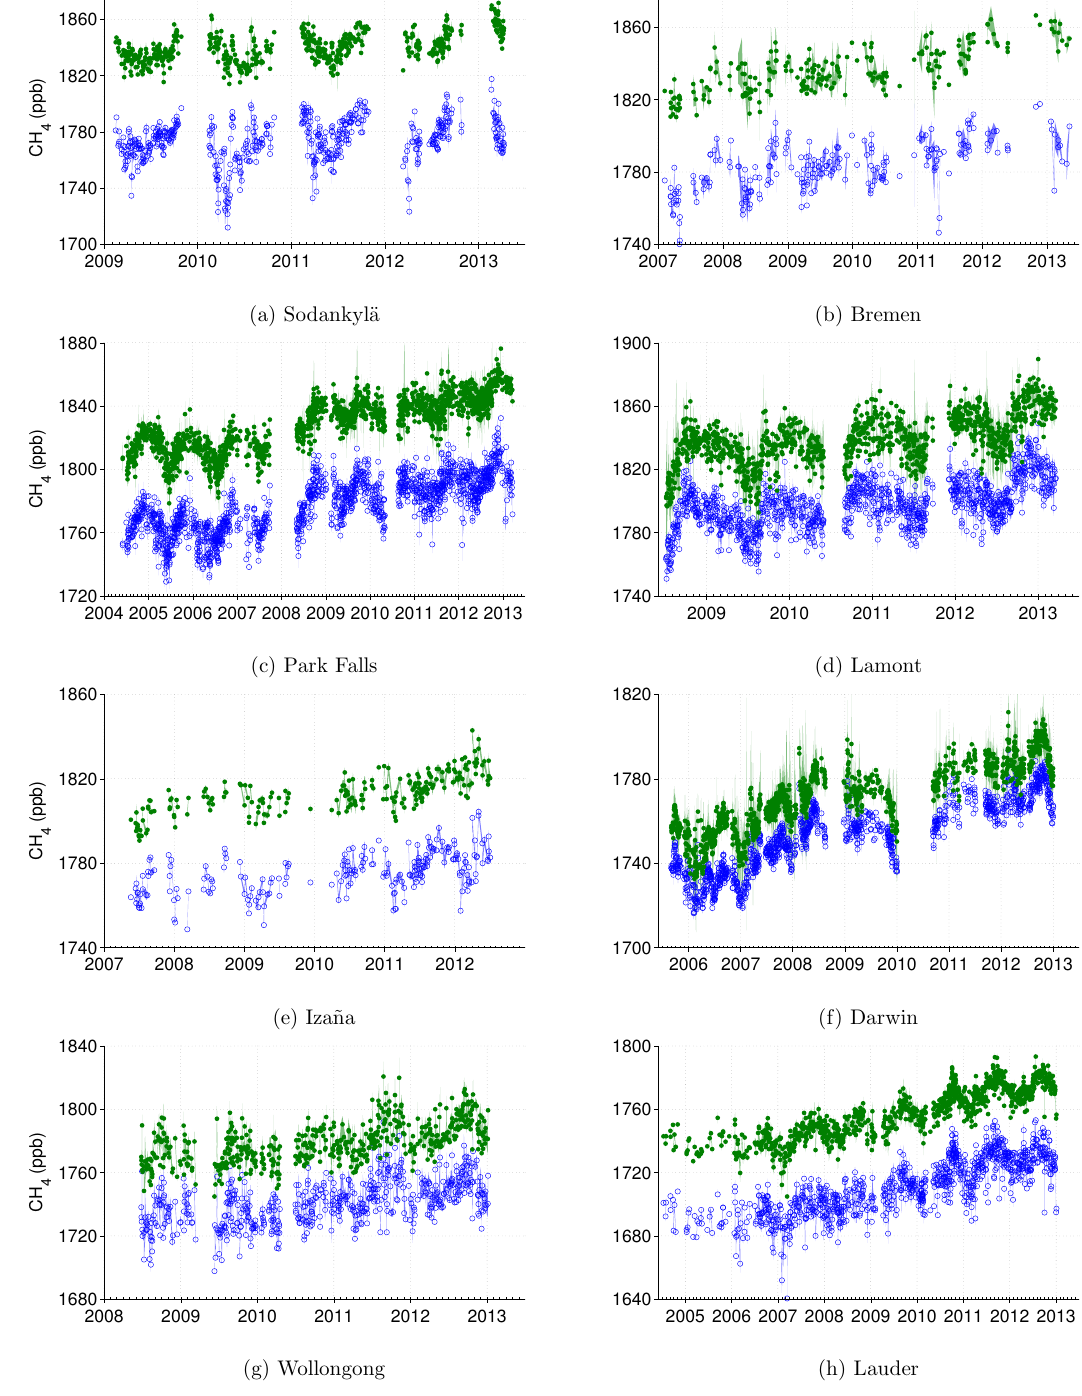
Figure 4. Daily median and standard deviation (shading) total (blue, open circles) and tropospheric (green, closed circles) column-averaged DMFs of CH 4 at (a) Sodankylä, Finland, (b) Bremen, Germany, (c) Park Falls, Wisconsin, USA, (d) Lamont, Oklahoma, USA, (e) Izaña, Tenerife, Canary Islands, (f) Darwin, Australia, (g) Wollongong, Australia and (h) Lauder, New Zealand. Only days with more than 10 measurements of tropospheric CH 4 with errors of < 1% are shown. Both the 120HR (June 2004–December 2010) and 125HR (Febru- ary 2010–December 2012) instruments are plotted for